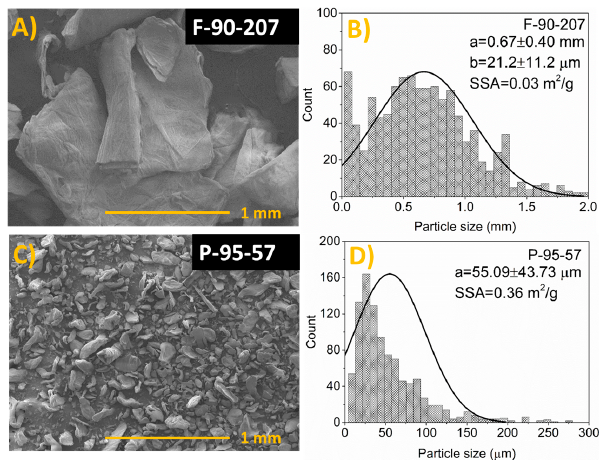
Figure 2. Chitosan in flakes and powder form ( A , C ) and their particle size distribution ( B , D ). The symbols a, b and SSA (in B and D ) represent the average particle size, thickness and the specific surface area, respectively.